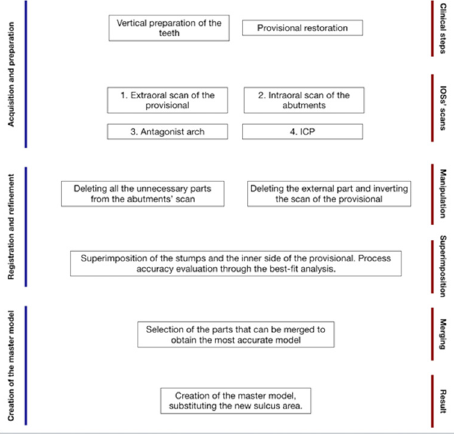
Figure 6. Schematic of the method.